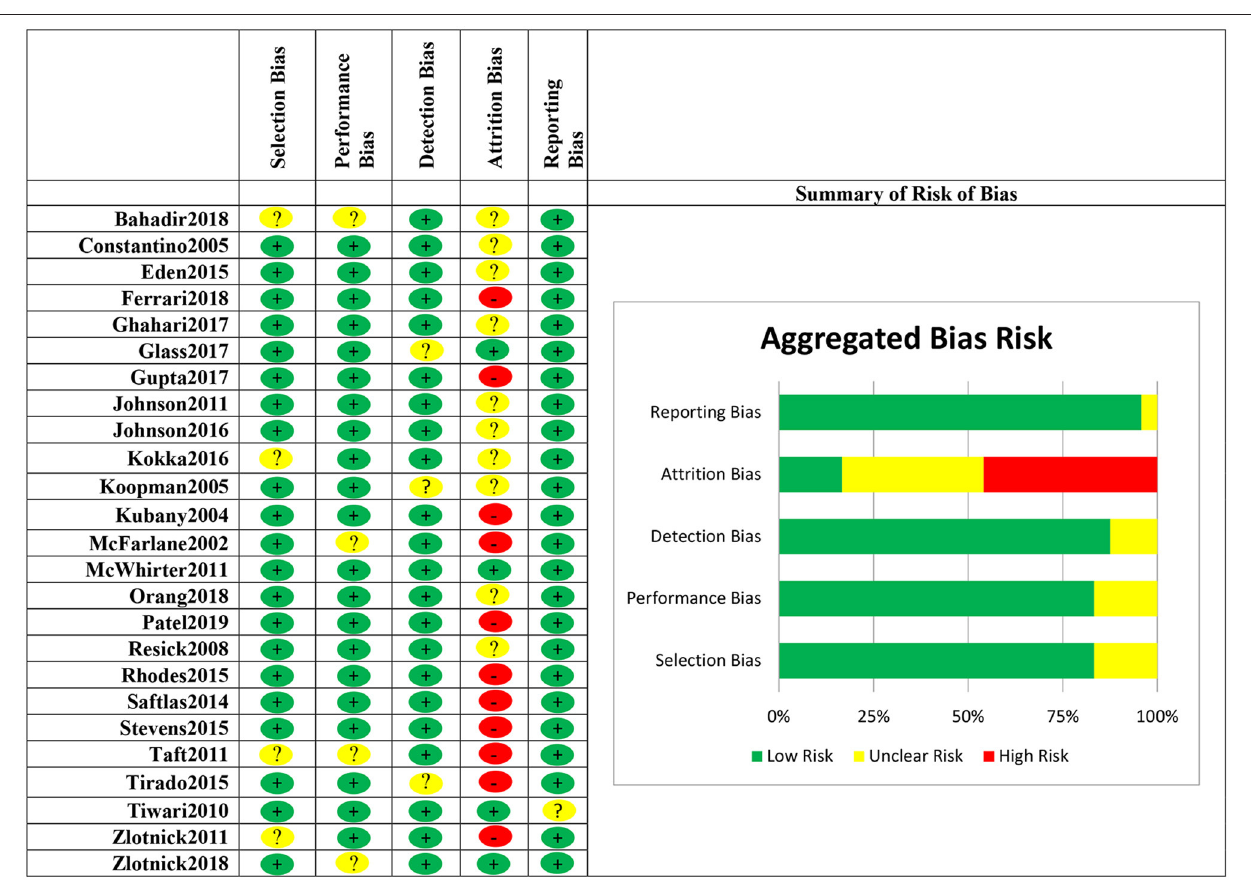
FIGURE 2 | Risk of bias for included studies in the meta-analysis for treatments for female victims of intimate partner violence.